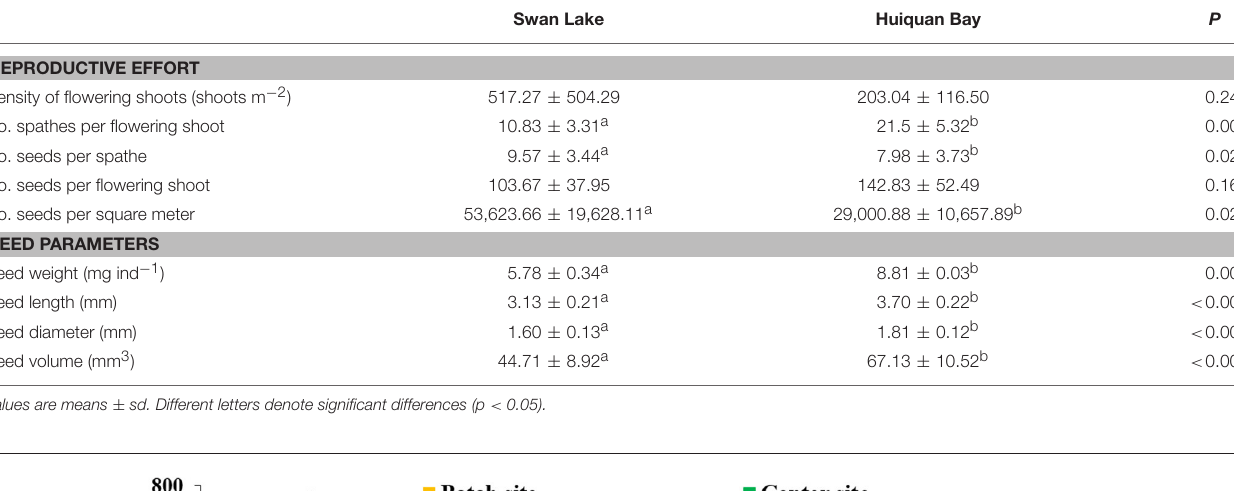
TABLE 2 | Reproductive effort and seed sizes of Zostera marina from Swan Lake and Huiquan Bay.